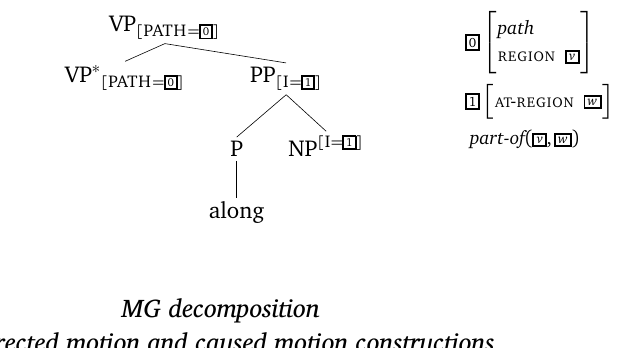
Revised elementary tree for